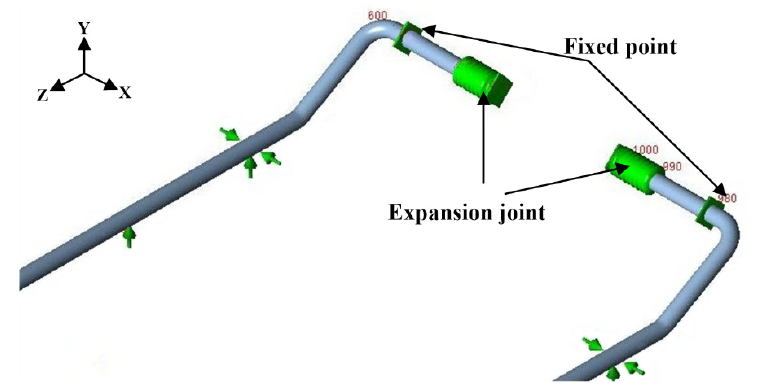
Figure 18. Schematic diagram of the expansion joint model.